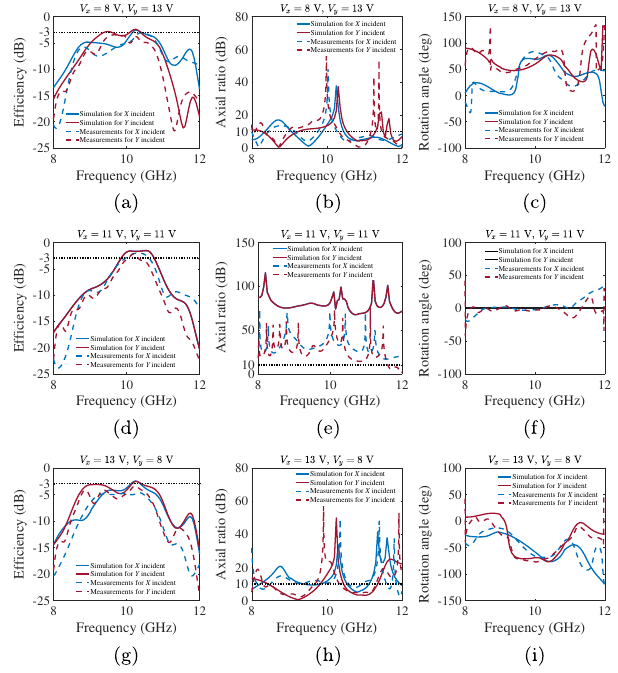
FIG. 15. Measurement results of efficiency, axial ratio, and rotation angle for the polarization rotator under three extreme biasing voltages